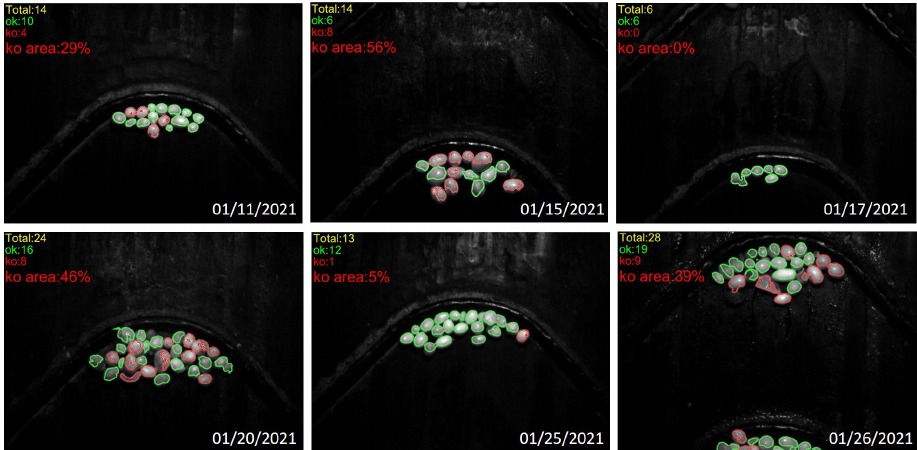
Figure 12. Exampleofdefectdetectionforimageslabelledaslowacquiredduringtheperiodof